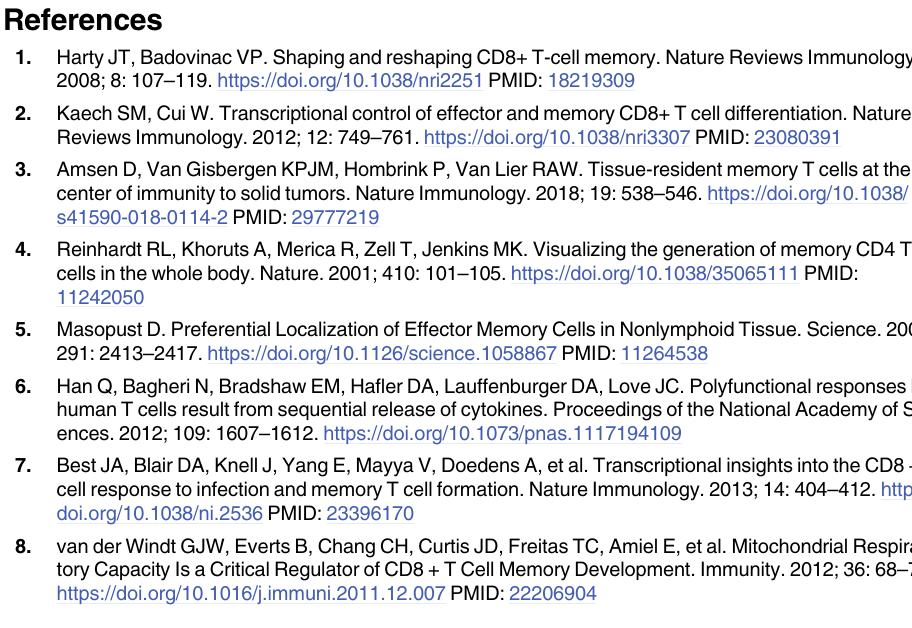
S1 Table. Transcriptome and proteome data in